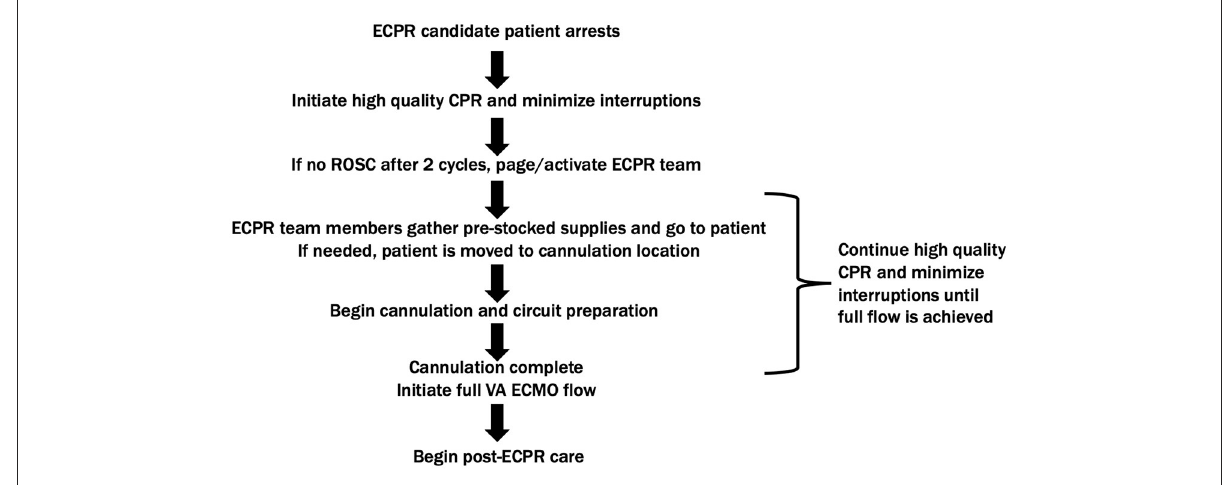
FIGURE1 ECPR deployment algorithm. ECPR, extracorporeal cardiopulmonary resuscitation; CPR, cardiopulmonary resuscitation; ROSC, return of spontaneous circulation; VA ECMO, veno-arterial extracorporeal membrane